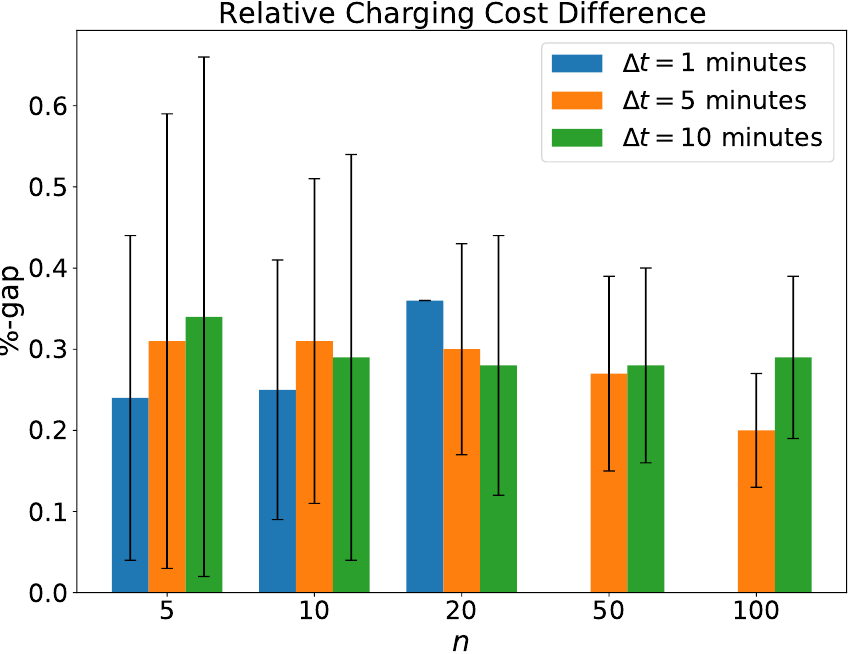
Figure 10. Mean charging cost gaps of EVS-SOC-LIN and EVS-SOC-GLIN with P gridmax = 40 n . Whiskers indicate the standard deviations. Note that for n = 20 and ∆ t = 1 only a single instance was solved to optimality, and therefore the corresponding standard deviation is